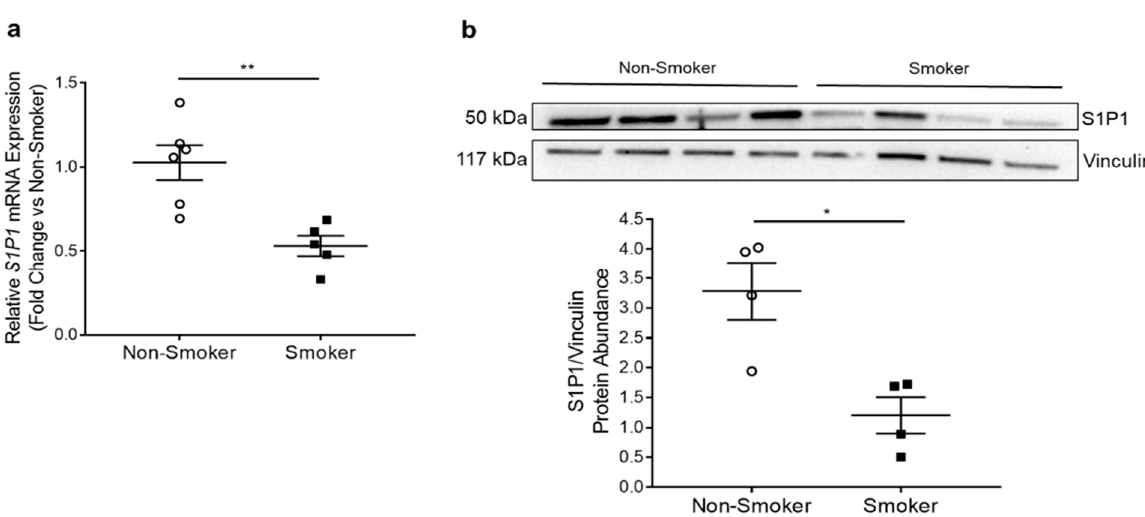
Figure 2. S1P1 in HLMVECs from Non-Smokers and Smokers. ( a ) Relative S1P1 mRNA expression in HLMVECs isolated from non-smoker (n = 6) and smoker (n = 5) donors measured by RTqPCR, normalized to the housekeeping gene human 18S (H18S) using 2 − ∆∆ CT method and expressed as a fold-change versus control (non-smoker). ** p = 0.0035; 2-tailed unpaired Student’s t -test. ( b ) Representative Western blot and densitometry analysis of S1P1 protein abundance relative to vinculin loading control in non-smoker and smoker HLMVECs (n = 4; 20 µ g protein/well). * p = 0.01; 2-tailed unpaired Student’s t -test. All graphs show data points, each representing an individual donor; horizontal lines are mean ± SEM.